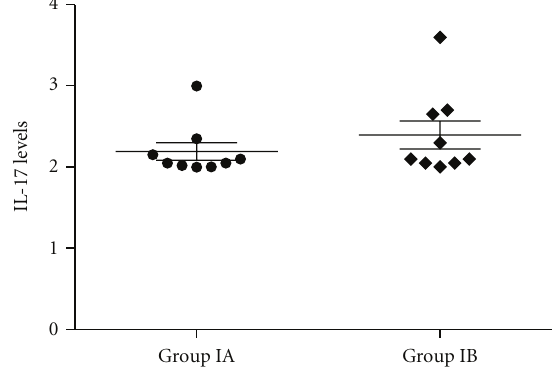
Figure 5: Serum IL-17 levels of severe persistent asthma patients were shown in dot-plot graph ( P = 0 .